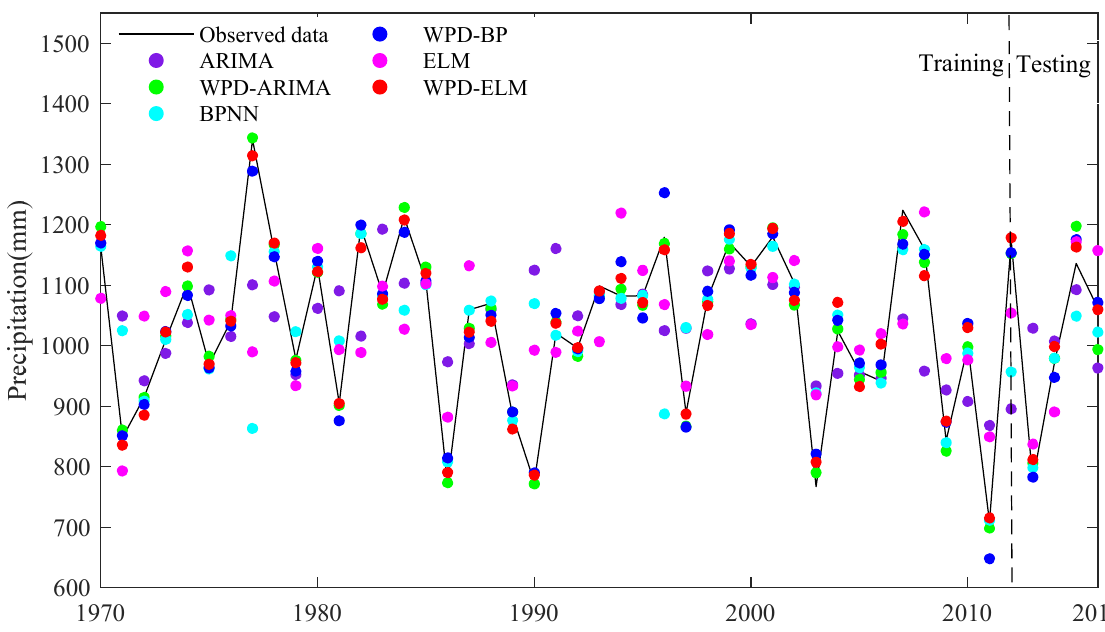
Figure 7. Observed and forecasted results during training and testing periods by six methods.